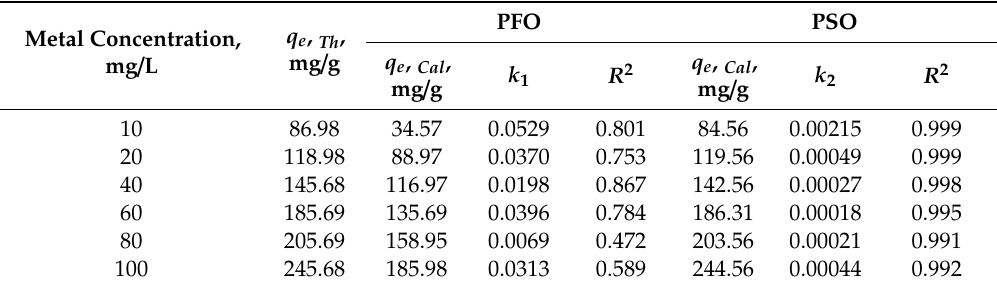
Table 1. La 2 O 3 nanorods adsorptive removal kinetics parameters for As(V) (10.0–100 mg / L) at pH 6.0, 25 ◦ C for 60 min equilibrium time with 0.1 g / L nanorods.